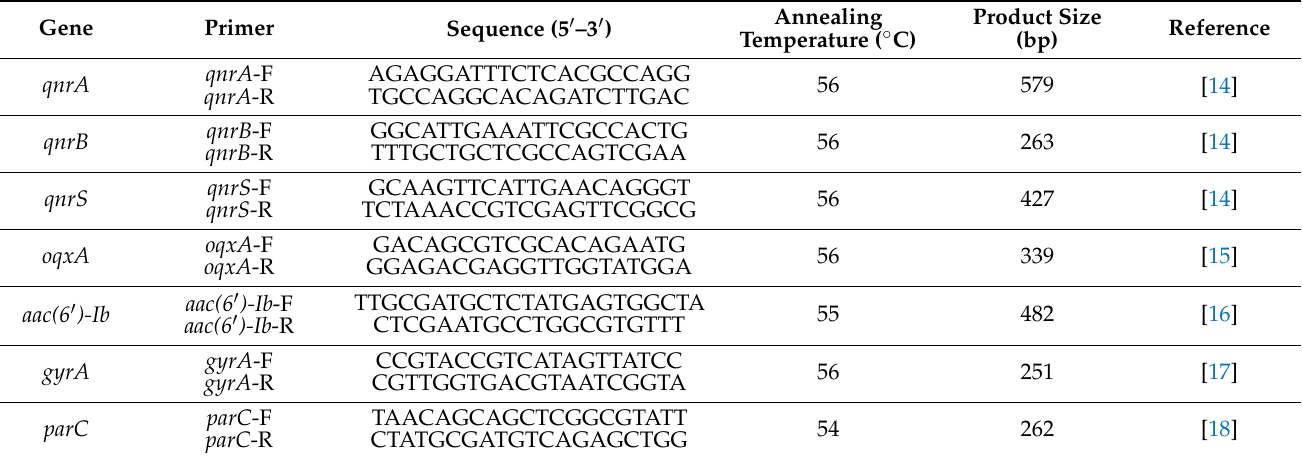
Table 1. PCR primers and annealing temperatures for target DNA